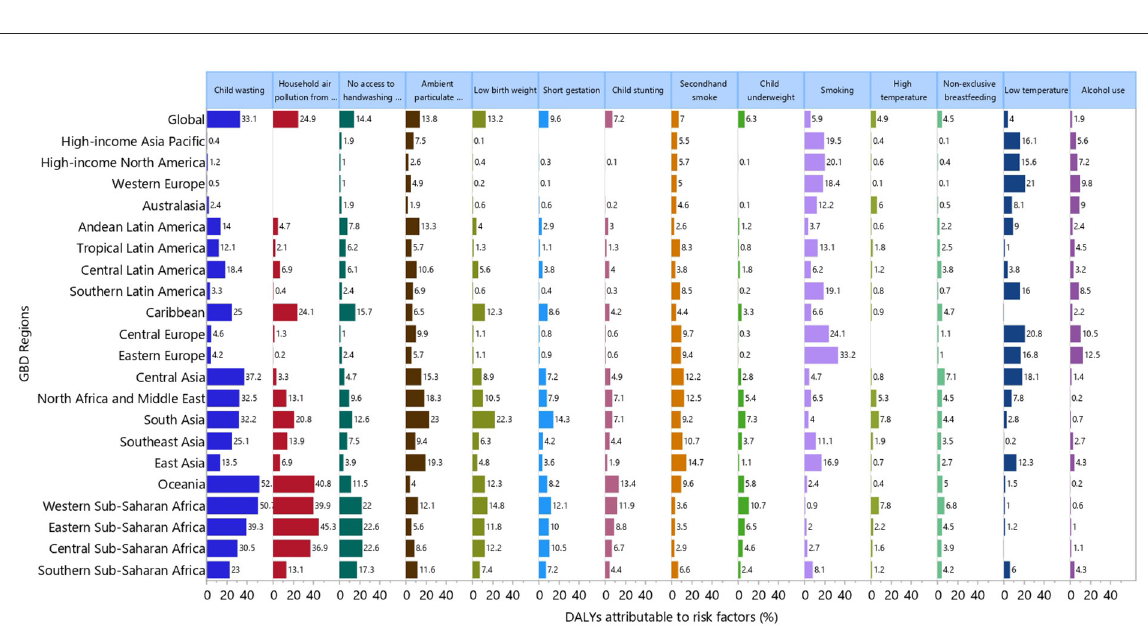
peaked in the < 1-year age group and then decreased with increasing age, before increasing in the older age groups (Supplementary Figure